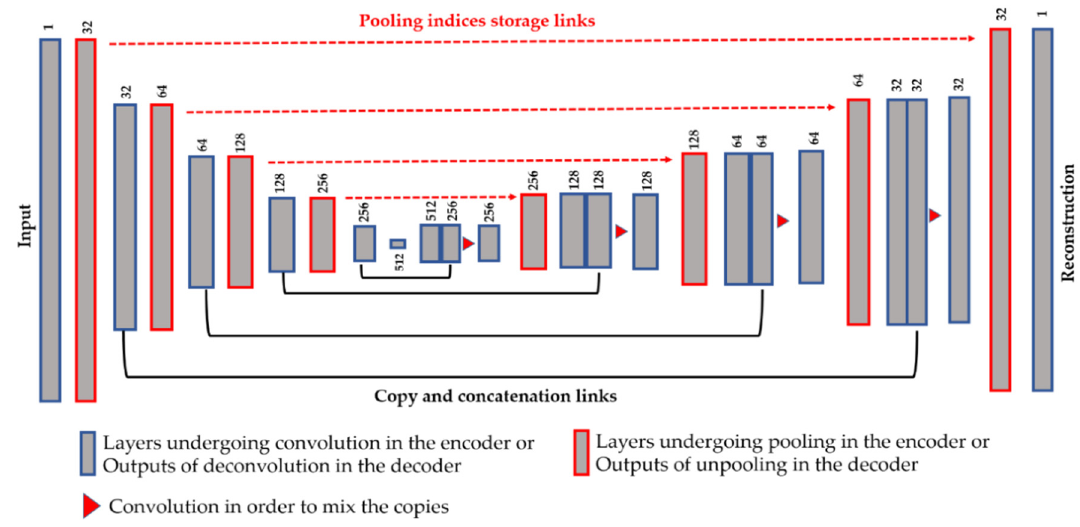
Figure 4. Illustration of the proposed network using the storage and copy / concatenate techniques at the same time. The dimensions shown above each layer refers to the number of features maps (the depth of the volume). See Table 1 for the spatial dimensions of each volume.